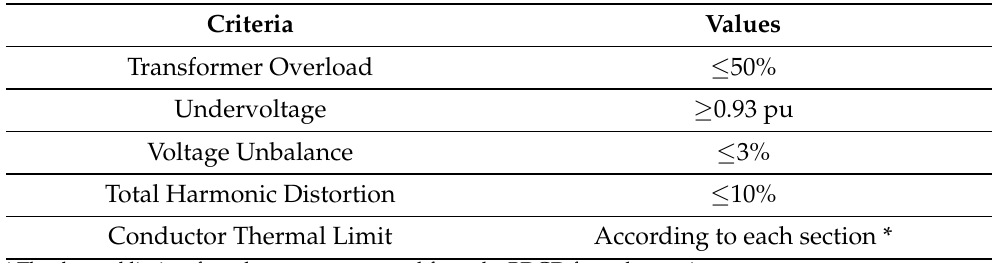
Table 2. Evaluation criteria